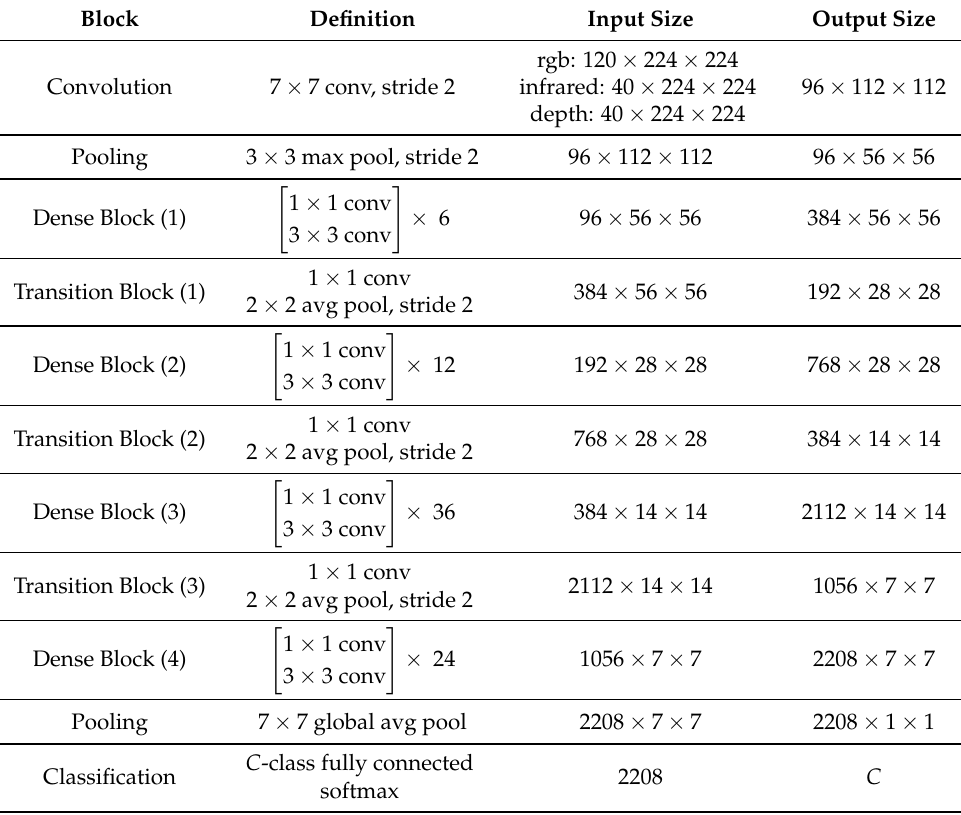
Table 2. Architectural details of the proposed model. It is derived from DenseNet-161 [22] to take sequence clips of 40 frames as input and to predict a distribution over C